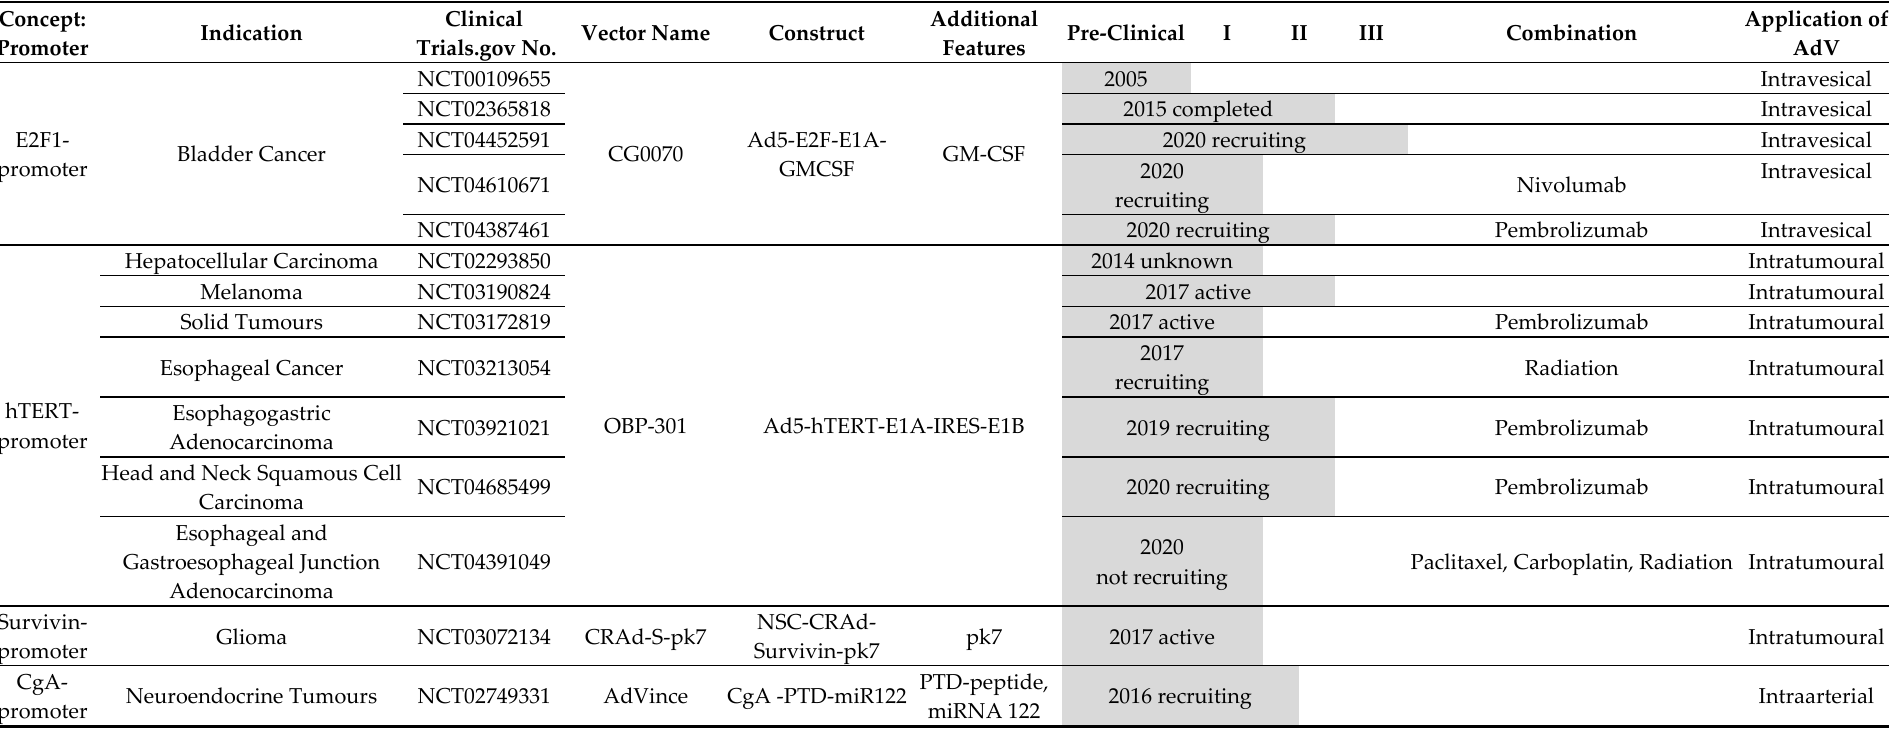
Table 1. Clinical trials using oncolytic adenoviruses whose replication is controlled by cellular promoters.